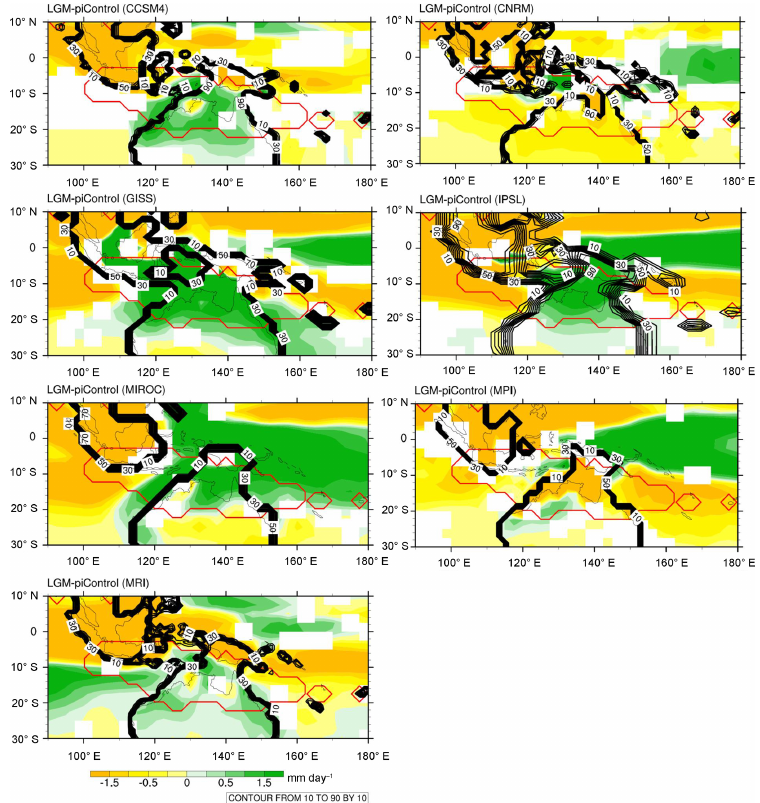
Figure 13. DJF mean precipitation differences between LGME and piControl derived from each model. The red lines enclose the monsoon domains. The dark black lines show the land area fraction used for the LGME in each model. Only those areas where the signal-to-noise ratio exceeds 1 are plotted.